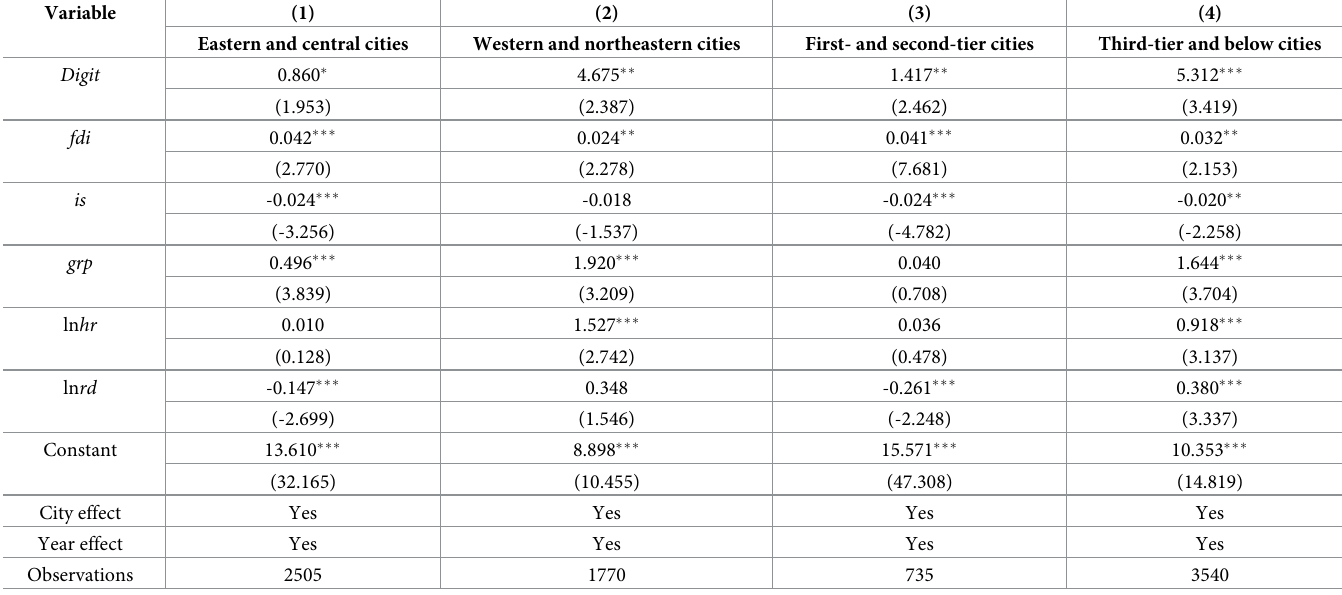
Table 4. Results of heterogeneity test.